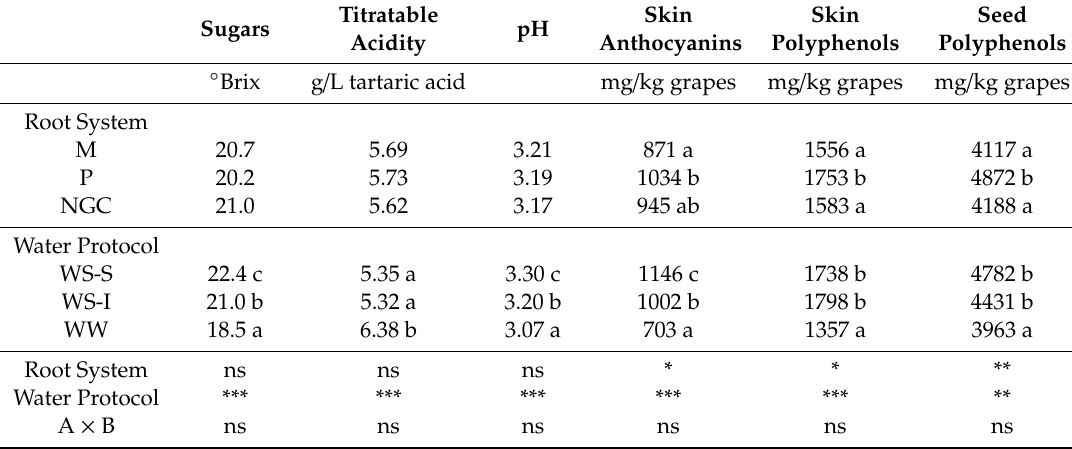
Table 2. Technological maturity and phenolic compound contents (by UV-VIS spectrophotometry) at harvest on grapes of Pinot noir vines grafted on Mgt 101-14 (M), 1103 Paulsen (P), and not grafted vines (NGC), treated with three irrigations protocols (WS-S, WS-I, and WW). Data were subjected to two-way ANOVA: *, **, ***, ns indicate significant di ff erences at P < 0.05, 0.01, 0.001, or not significant.